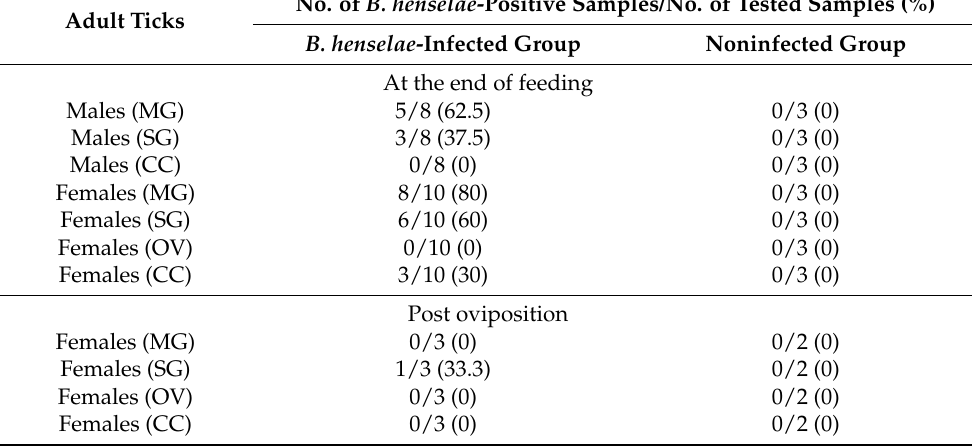
Table 2. Bartonella henselae DNA detection from tick samples dissected at the end of adult feeding on B. henselae -infected or noninfected goat blood through artificial membrane feeding system and post oviposition. No. of B. henselae -Positive Samples/No. of Tested Samples (%) Adult Ticks